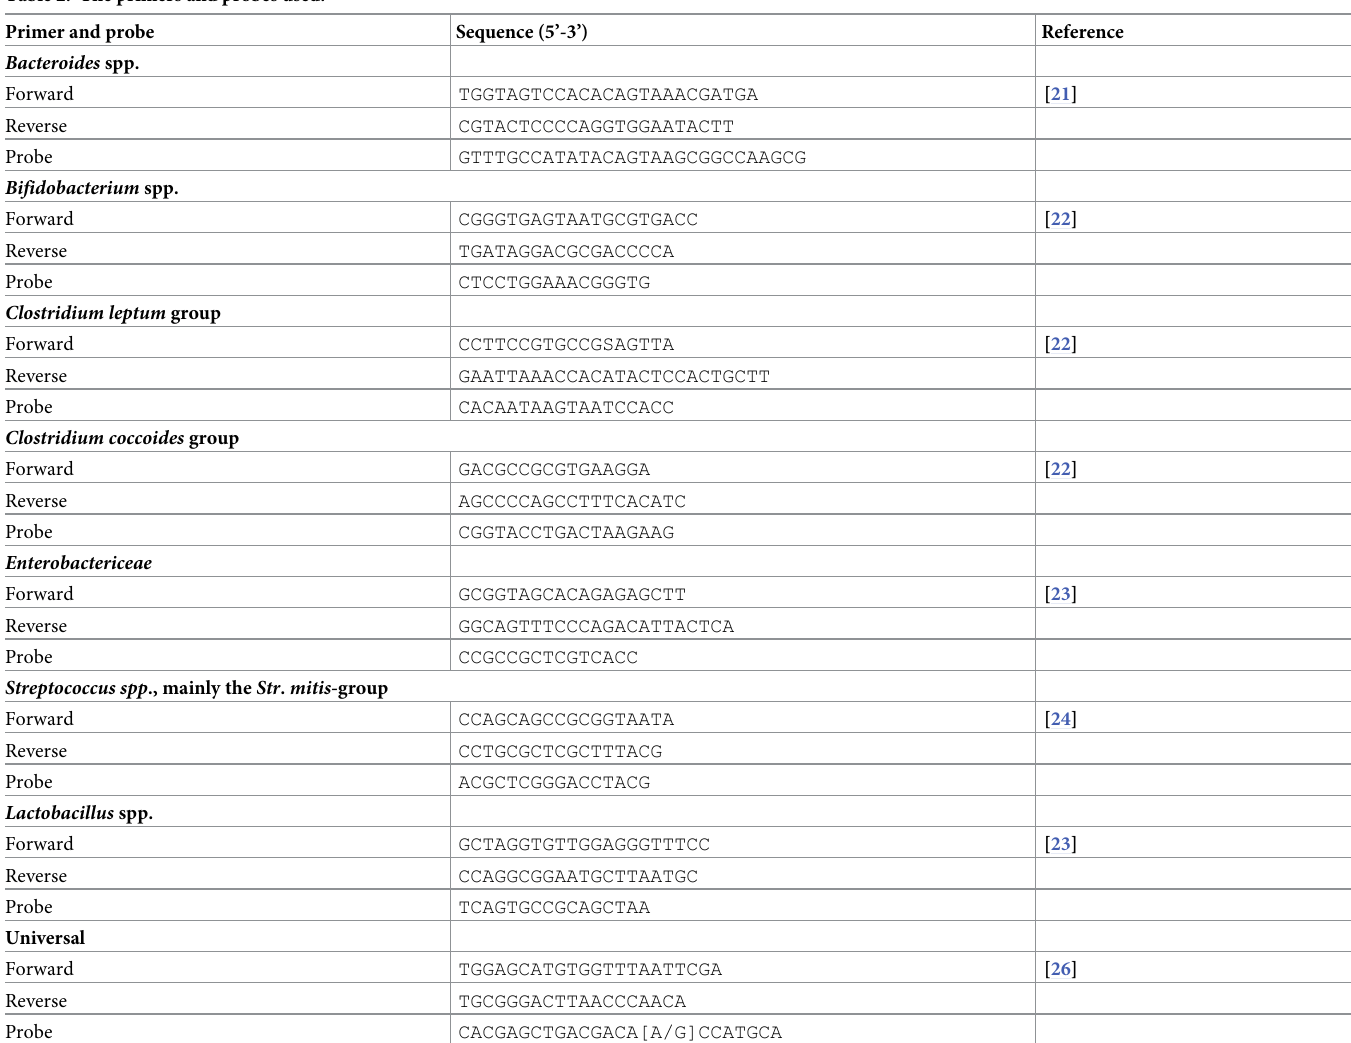
Table 2. The primers and probes